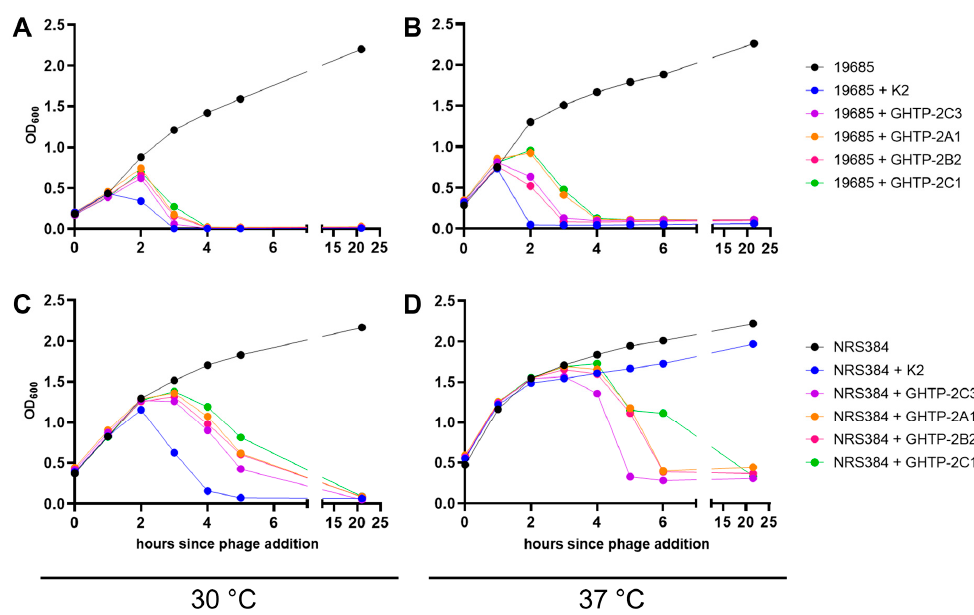
Figure 5. Culture lysis times for phage K with wild-type or mutant gp102 , under permissive ( A – C ) and non-permissive ( D ) infection conditions. ( A ) ATCC 19685 growing at 30 °C, ( B ) ATCC 19685 growing at 37 °C, ( C ) NRS384 growing at 30 °C, and ( D ) NRS384 growing at 37 °C. These data are representative of two replicate experiments.